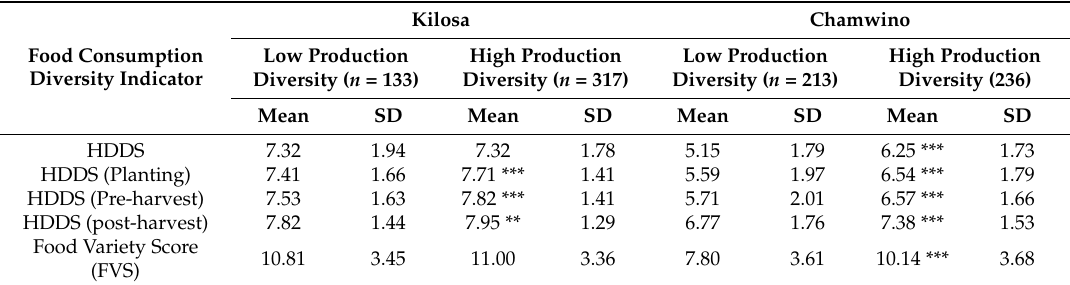
Table 3. Comparison of food consumption diversity based on crop-livestock diversity. Kilosa Chamwino Food Consumption Low Production High Production Diversity Indicator Diversity ( n = 133) Diversity ( n =